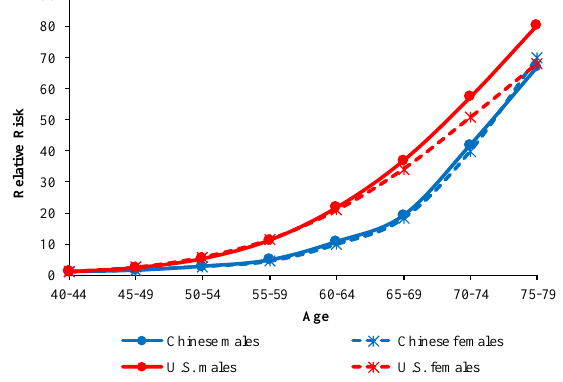
Figure 5. Age effects on COPD mortality by sex in China and the U.S.